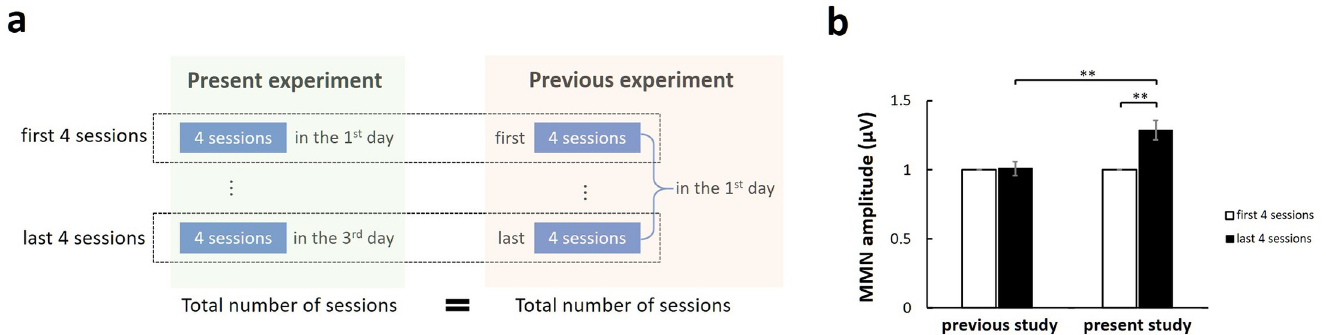
Fig 7. Algorithms (a) and results (b) compared with a previous study: The average MMN amplitude of the NF group for the target words “light” and “right” on the first and last four sessions in the previous and present study. Error bars for the data are SEM; �� p < 0.01.